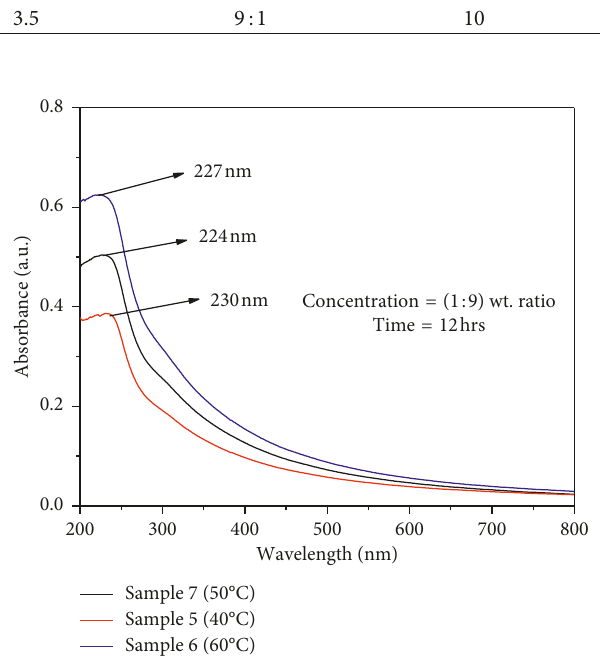
Figure 2: UV-Vis spectra at different temperatures. Table 3: Synthesis of GO at different reaction time periods.